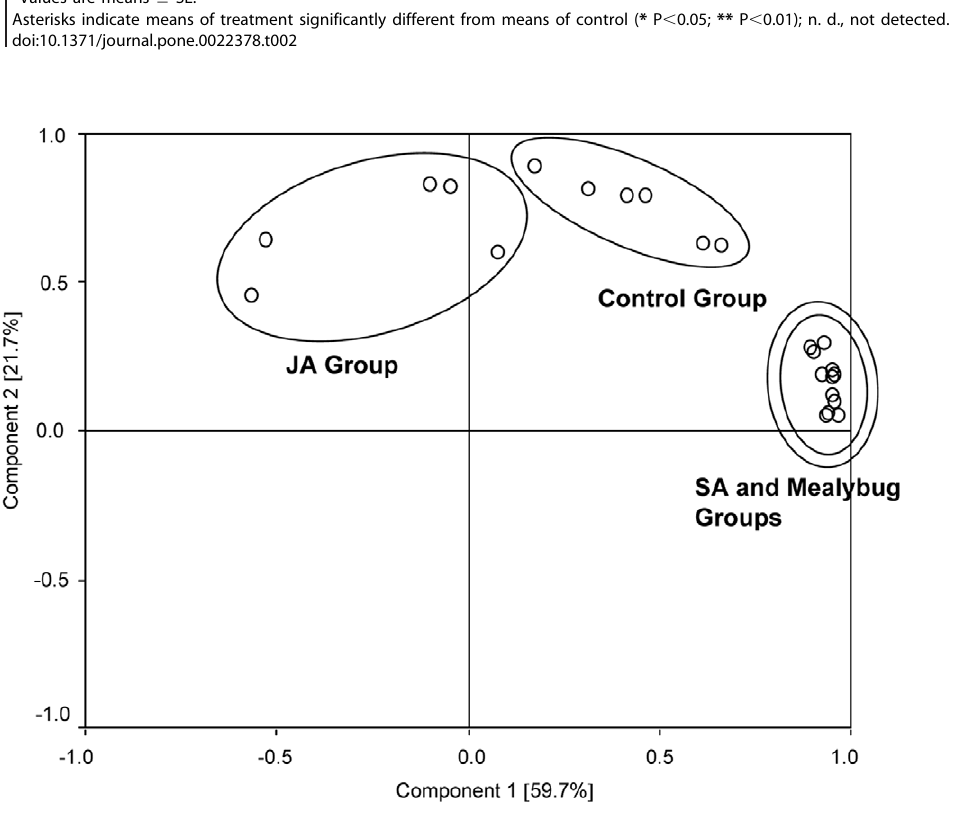
Figure 2. Principal component analysis (PCA) of volatile pattern of plants from different treatments. Control group, undamaged plants; Mealybug Group, plants infested with 50 of mix-aged P. solenopsis ; JA Group, jasmonic acid-treated plants; SA Group, salicylic acid-treated plants. First and second principal component plotted against each other. Percentage variation explained between brackets. doi:10.1371/journal.pone.0022378.g002 PLoS ONE |